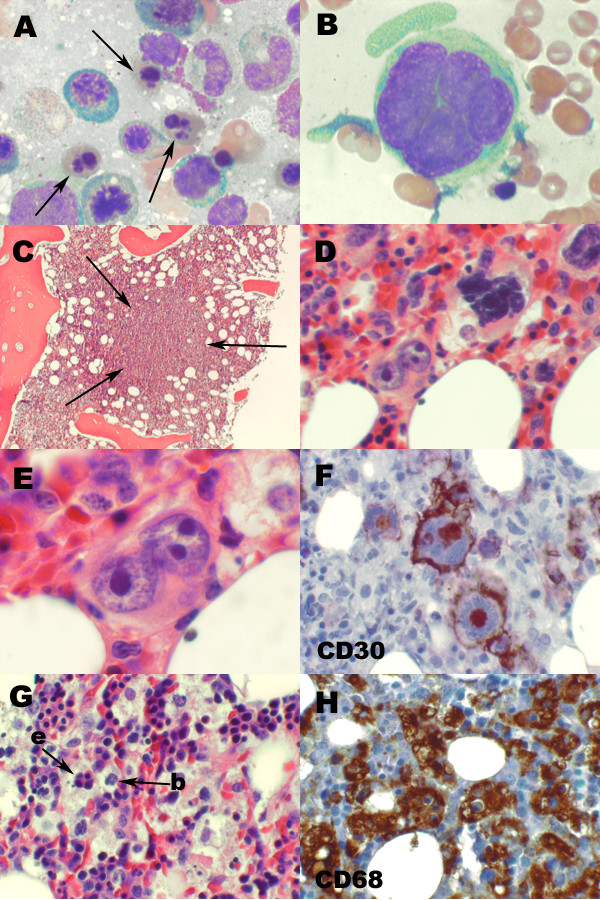
Bone marrow. (A) Aspirate smears show many dysplastic erythroid precursors with bizarre nuclear configurations (arrows) as well as (B) rare tumor giant cells (Wright Giemsa, original magnification ×1000). (C) Ill-defined tumor nodules efface the bone marrow architecture within the core biopsy (hematoxylin and eosin, ×100). (D) The tumor nodules contain many irregular mononuclear cells as well as scattered bizarre multinucleated tumor giant cells with hyperchromatic nuclei with coarse chromatin and macronucleoli (hematoxylin and eosin, ×400). (E) Occasional binucleated Reed-Sternberg like tumor cells are present (hematoxylin and eosin, ×1000). Immunohistochemical studies performed on the bone marrow core biopsy are consistent with classical Hodgkin lymphoma. (F) The tumor cells are strongly positive for CD30 expression with membranous and Golgi positivity (×400). (G) Within the bone marrow core biopsy, there is a conspicuous background histiocytosis with prominent hemophagocytosis (hematoxylin and eosin, ×400). Arrows indicate phagocytosed erythroid precursors (e) as well as an ingested band form (b). (H) An immunohistochemical stain for CD68 highlights abundant background histiocytes, many of which contain hematopoietic elements (×400).